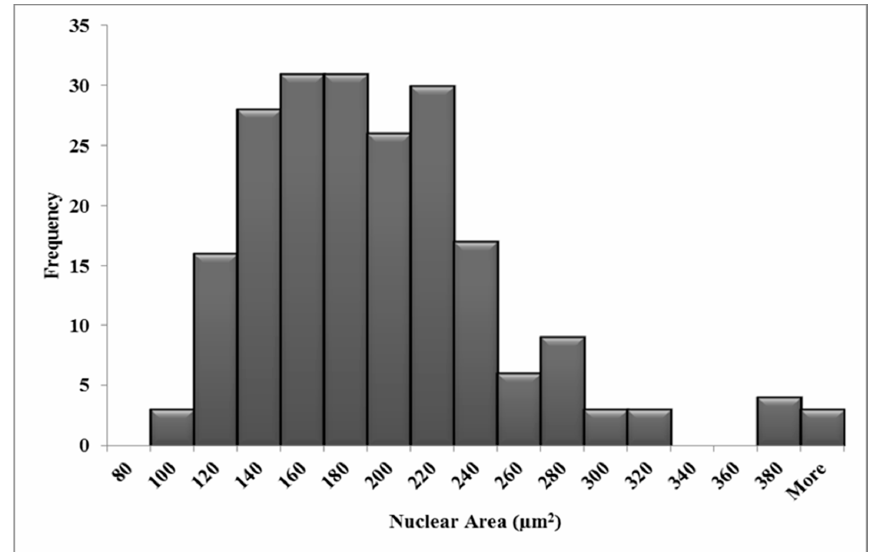
Figure 3. Measured nuclear area distributions for the HF19 cell line. The mean area is 189 µm 2 for 211 cells over three experiments.